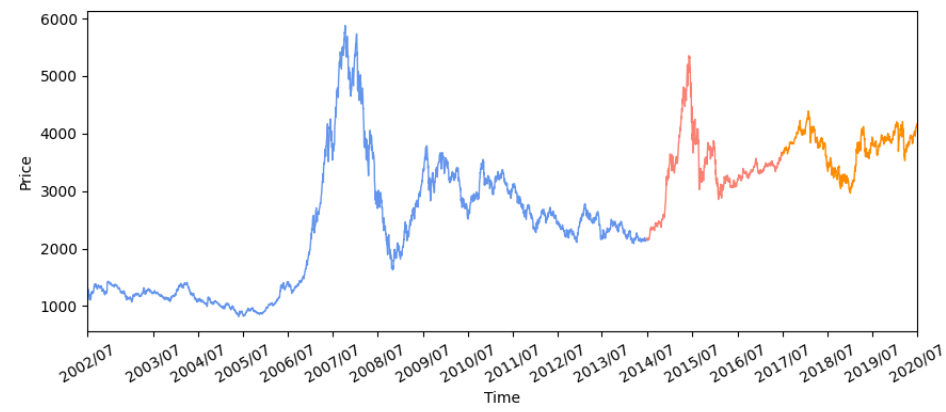
Figure 2. Daily closing price of IF300.